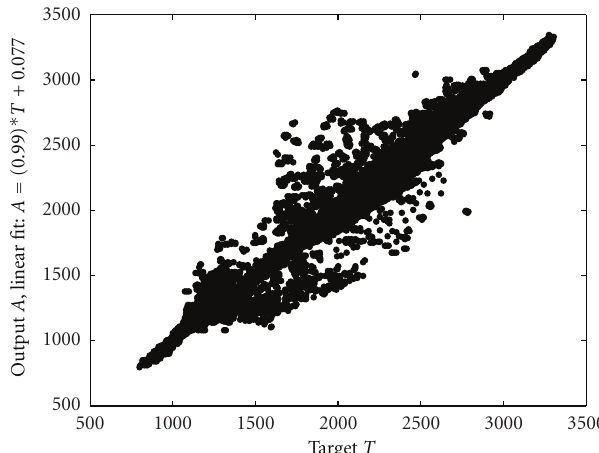
Figure 9: Comparison between TNN output and target in-cylinder temperature (test data).